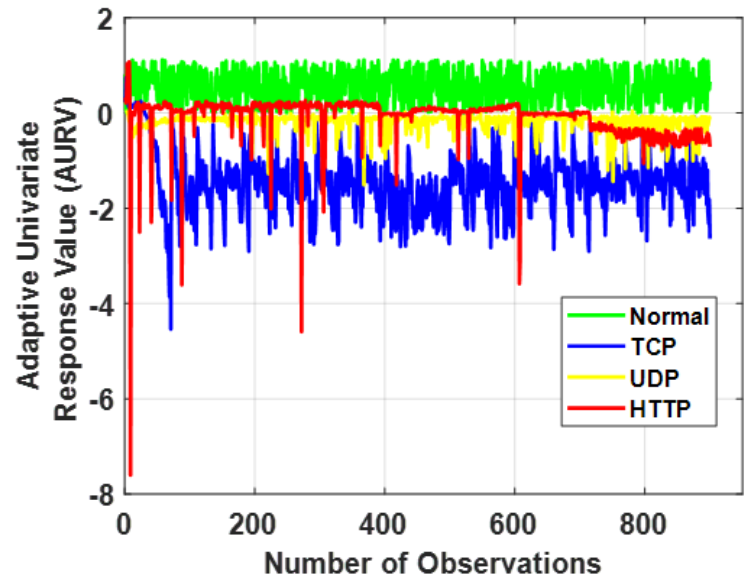
Figure 8. Trend of the AURVs for T p , J t and R t metrics for all the SDN